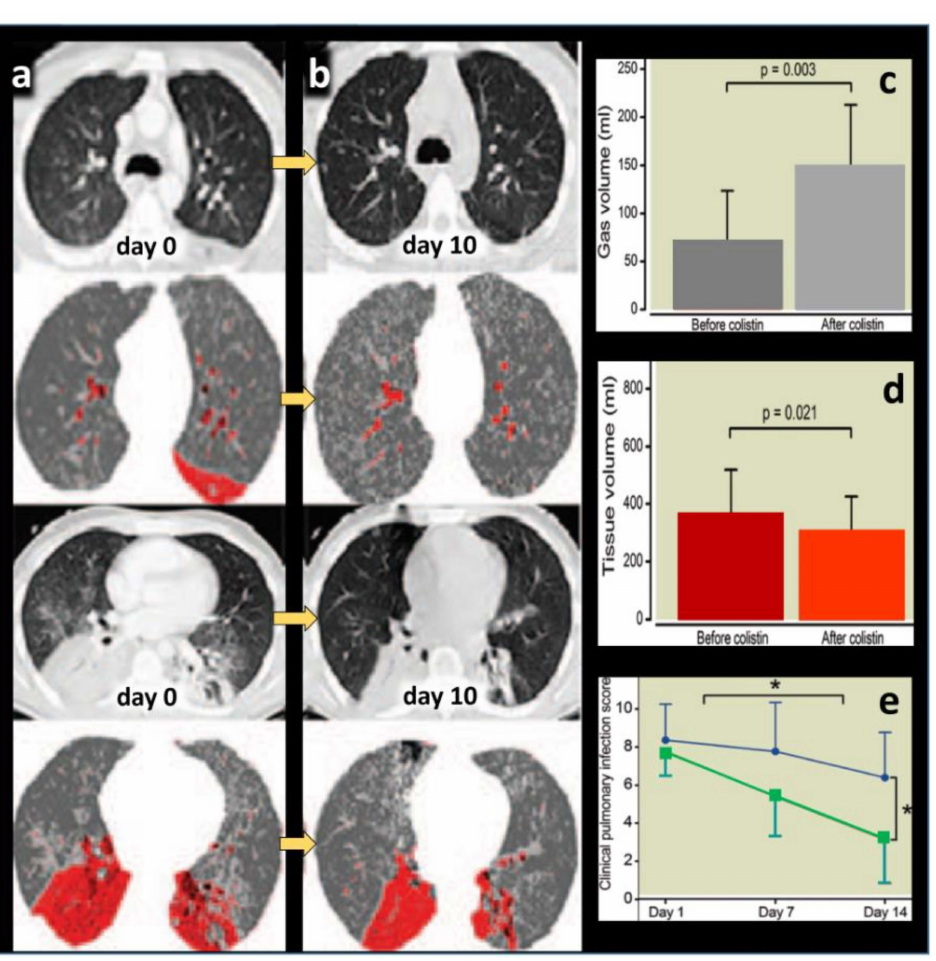
Figure 2. Representative computed tomography images obtained in a patient with ventilator- associated pneumonia (VAP) caused by multidrug-resistant Pseudomonas aeruginosa and treated by nebulized colistimethate sodium (CMS) 5 million international units × 3 /24 h for 10 days. A color encoding system identifies normally aerated lung regions (dark grey), poorly aerated lung regions (light grey) and nonaerated consolidated lung regions (red). ( a ) Contiguous 10 mm thick computed tomography sections obtained before nebulization (day 0) shows bilateral consolidation of lower lobes with disseminated foci of interstitial pneumonia in upper lobes. ( b ) Ten days later, lung consolidations are partially reaerated, attesting to the clinical efficiency of nebulized CMS monotherapy. ( c , d ) Computed tomography quantitative assessment of gas volume (aeration) and tissue volume (inflammation/infection) before and after CMS (colistin) nebulization in seven patients with VAP caused by MDR Pseudomonas aeruginosa. Nebulized CMS monotherapy was associated with a significant re-aeration and decrease in inflammation/infection. ( e ) Changes in Clinical Pulmonary Infection Score in 29 patients with VAP caused by MDR Pseudomonas aeruginosa or Acinetobacter baumannii successfully treated by nebulized CMS (green color) and in 13 patients with VAP caused by MDR Pseudomonas aeruginosa or Acinetobacter baumannii unsuccessfully treated by nebulized CMS (blue color). * indicates p < 0.001